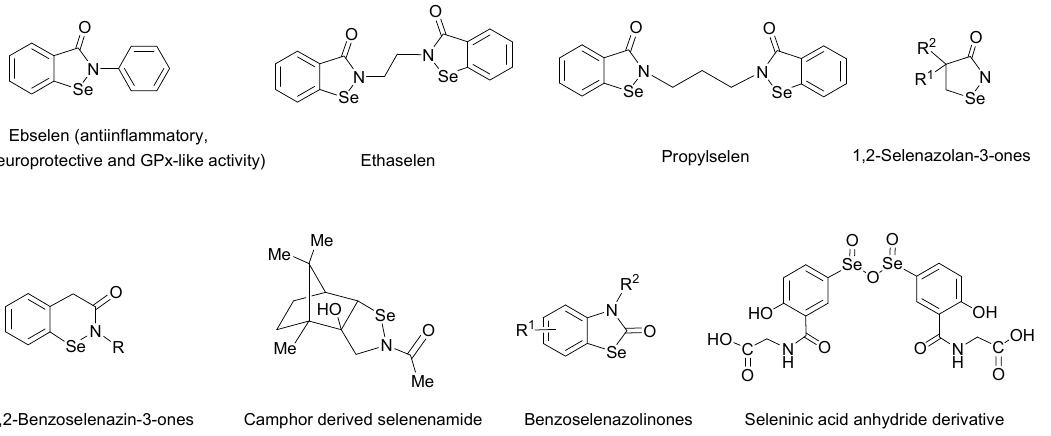
Figure 2. Containing amide group organoselenium compounds, which exhibit glutathione peroxidase-like activity.